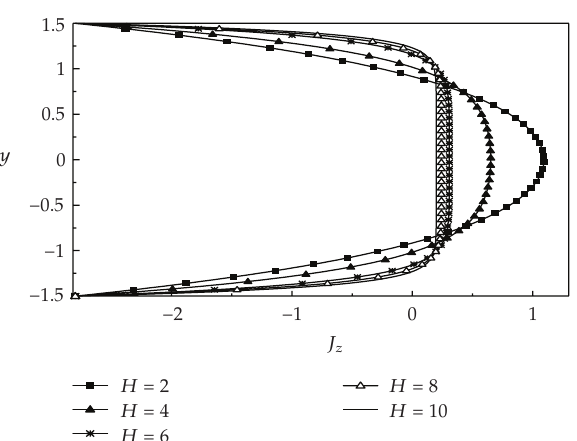
Figure 11: Variation of the current density distribution across the channel for α (cid:8) 0 . 5 , θ (cid:8) 1 . 6 , m (cid:8) 3 , N (cid:8) 0 . 2 , R m (cid:8) 1, and di ff erent values of H .